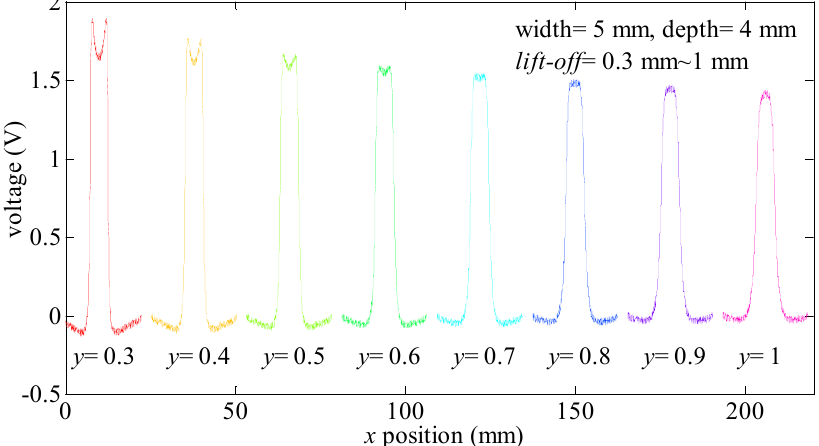
Figure 12. MFL signals obtained in different lift-off values.